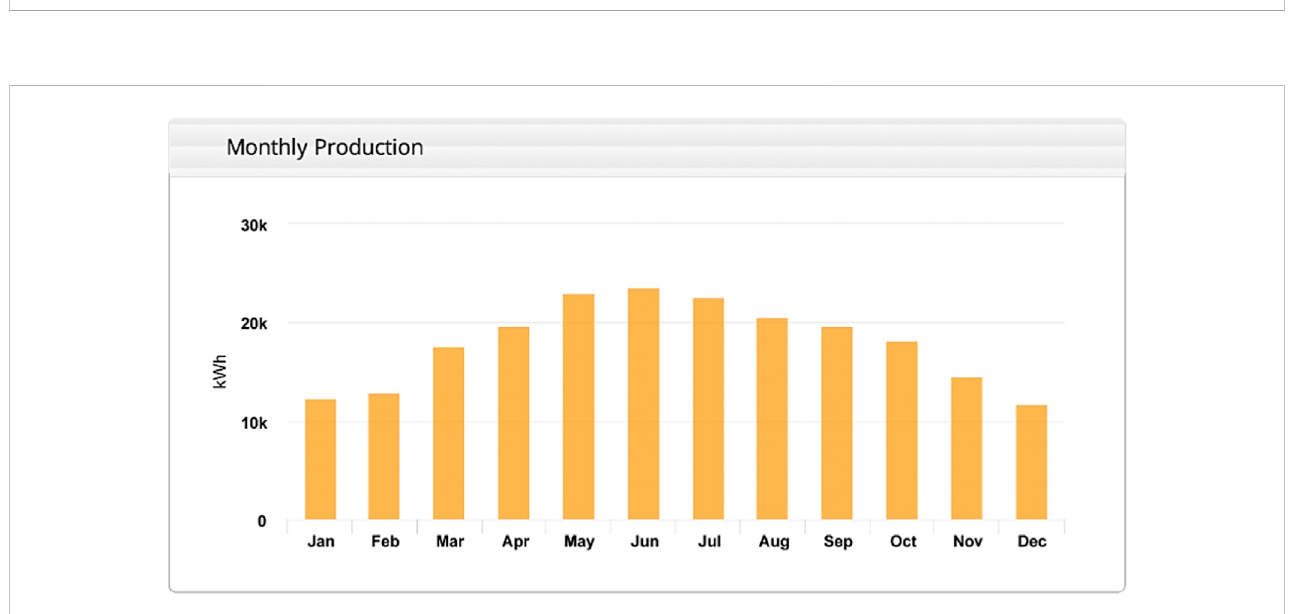
FIGURE 10 Monthly power production estimated by